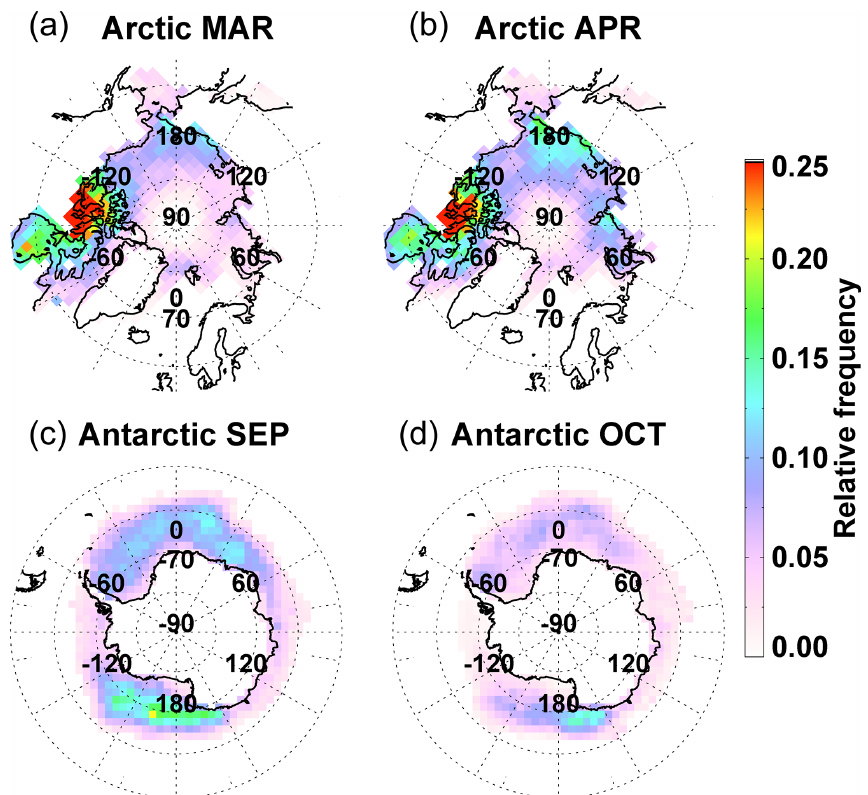
Figure 2. Monthly spatial distribution of the occurrence frequency of enhanced total BrO columns over the Arctic ( a March; b April) and Antarctic sea ice regions ( c September; d October) during the study period of